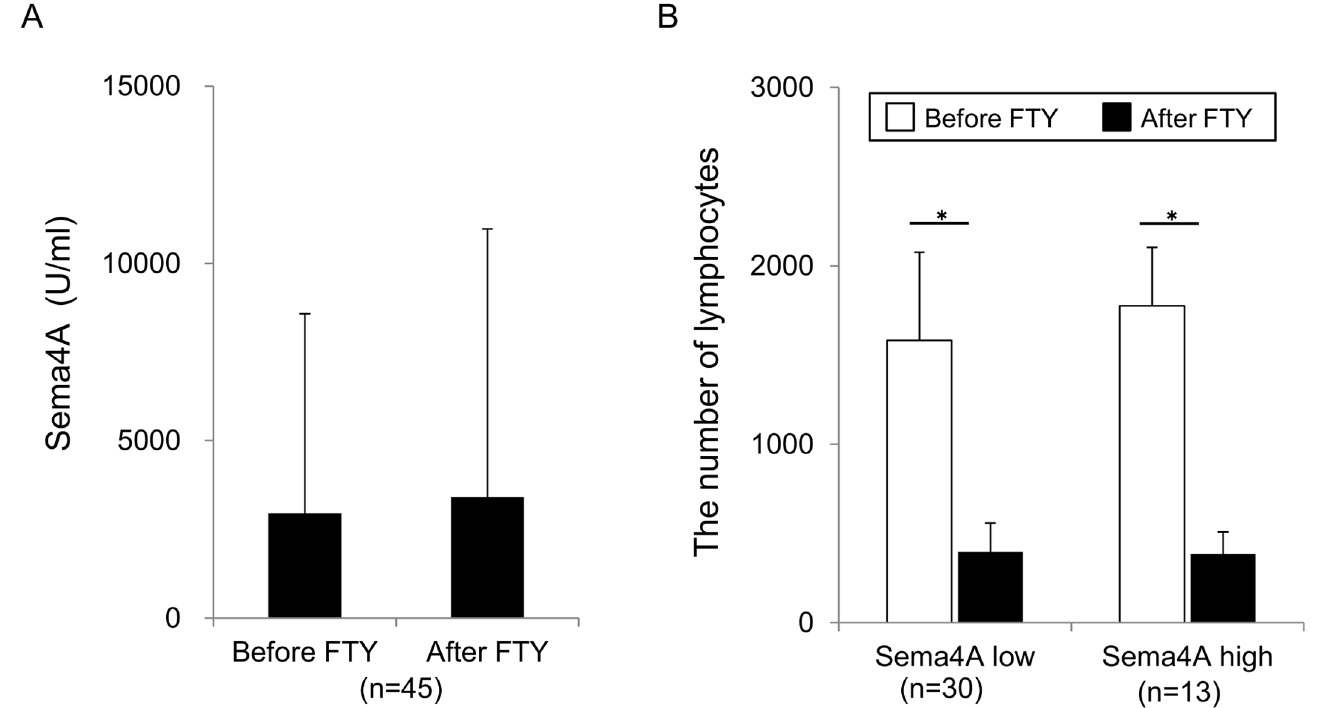
Fig 1. Effect of fingolimod on the levels of Sema4A and number of lymphocytes. (A) The levels of Sema4A are not affected by fingolimod. The serum Sema4A levels were measured before and 3 months after fingolimod therapy. Fingolimod therapy did not affect the Sema4A levels (p = 0.675, Welch’s t test). (B) The Sema4A levels did not affect lymphopenia under fingolimod treatment. The cell counts of lymphocytes were measured before and 3 months after fingolimod therapy. Fingolimod-induced lymphopenia were observed in both patients with high Sema4A levels and those with low Sema4A levels. Data represent the mean ± SD. (cid:3) p (cid:20)